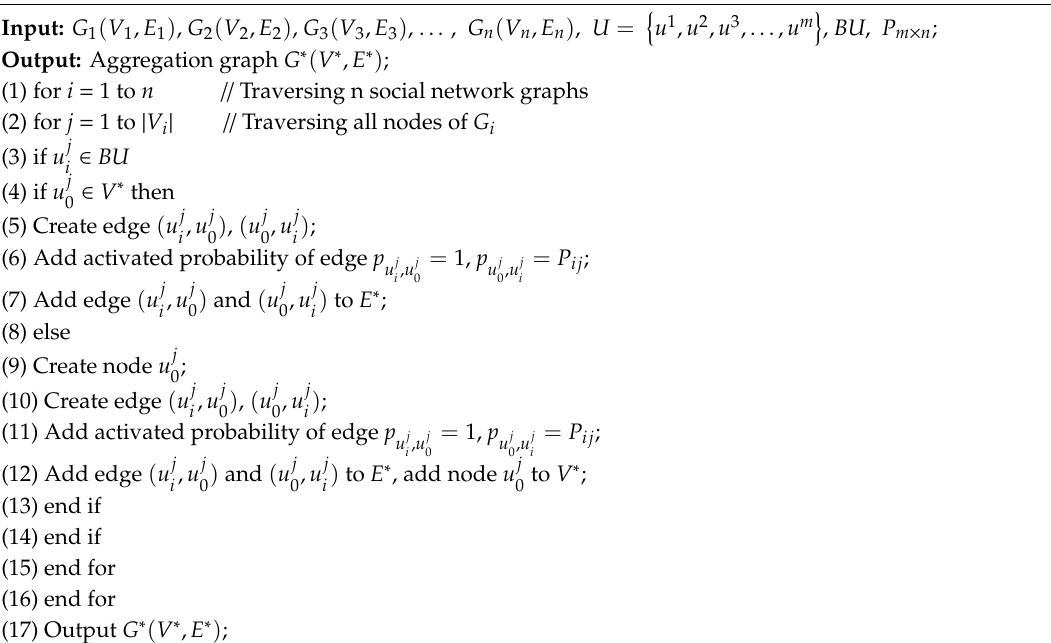
Algorithm 1. Multi-social networks aggregation algorithm based on Bridge